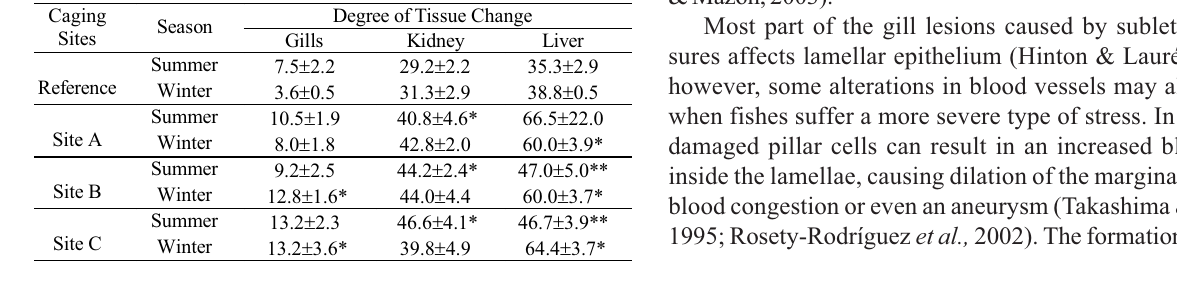
Table 4. Hepatic glycogen content and hepatocytes nuclear area and diameter of P. lineatus confined at reference site and at the 3 sites at Cambé stream (A, B and C), during winter and summer. Values indicate mean ± S.E. In the winter n=6 for the Reference, Site A and Site B, and n=5 for site C. In the summer n=6 for Reference and Site A, n=4 for Site B and n =5 for site C. * indicates value significantly different from the reference site, and # indicates value significantly different from the winter result ( P <0.05).